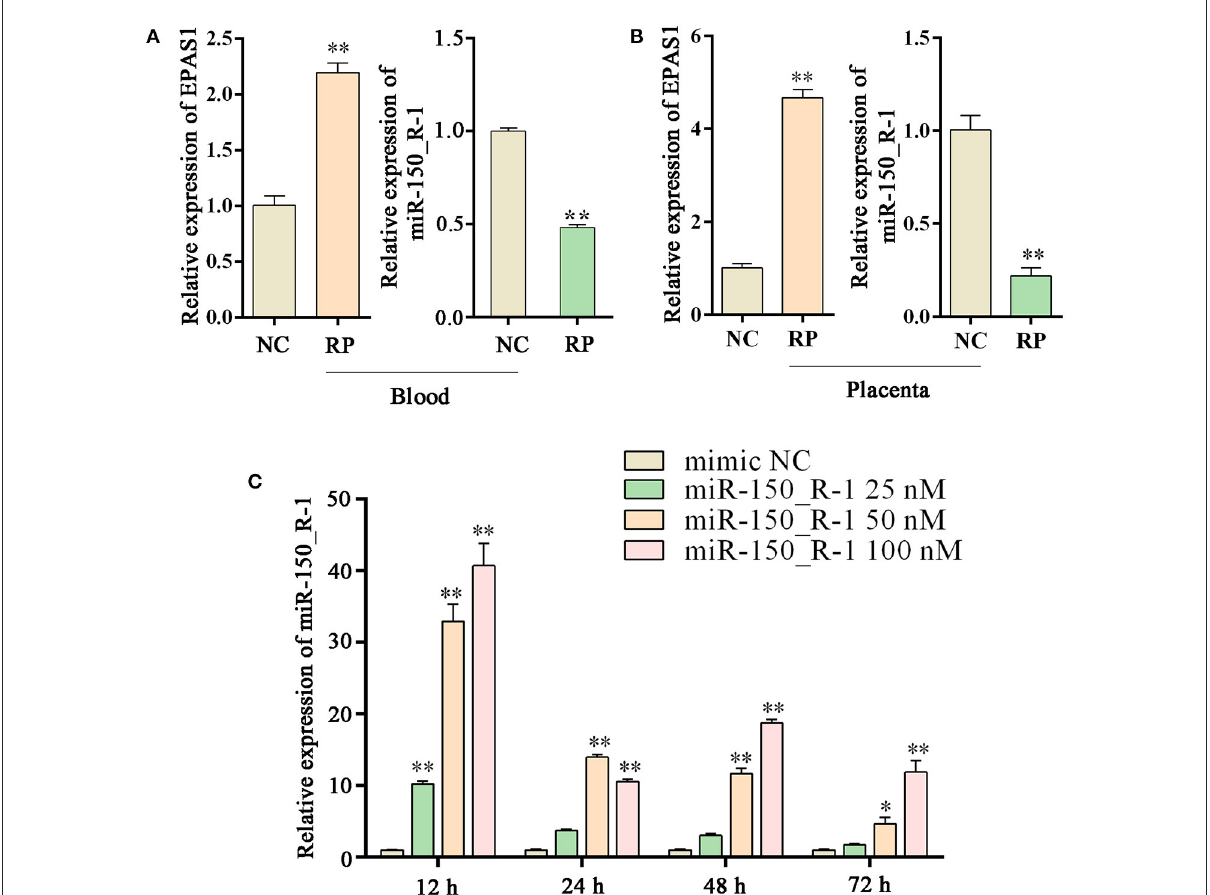
FIGURE5 Changes in EPAS1 and miRNA-150_R-1 in blood and placental tissues and transfection efficiency of miRNA-150_R-1 in BEND cells. (A) EPAS1 and miR-150_R-1 mRNA expression levels in NC and RP blood. (B) EPAS1 and miR-150_R-1 mRNA expression levels in NC and RP placental tissues. (C) At 12, 24, 48, or 72h and final mimic concentrations of 25, 50, or 100nM, the transfection efficiency of the mimic was verified using qPCR, with mimic NC used as a control. Data represent the mean ± SEM. * p < 0.05, ** p < 0.01. NC, fetal membranes of normal discharge; RP, retained